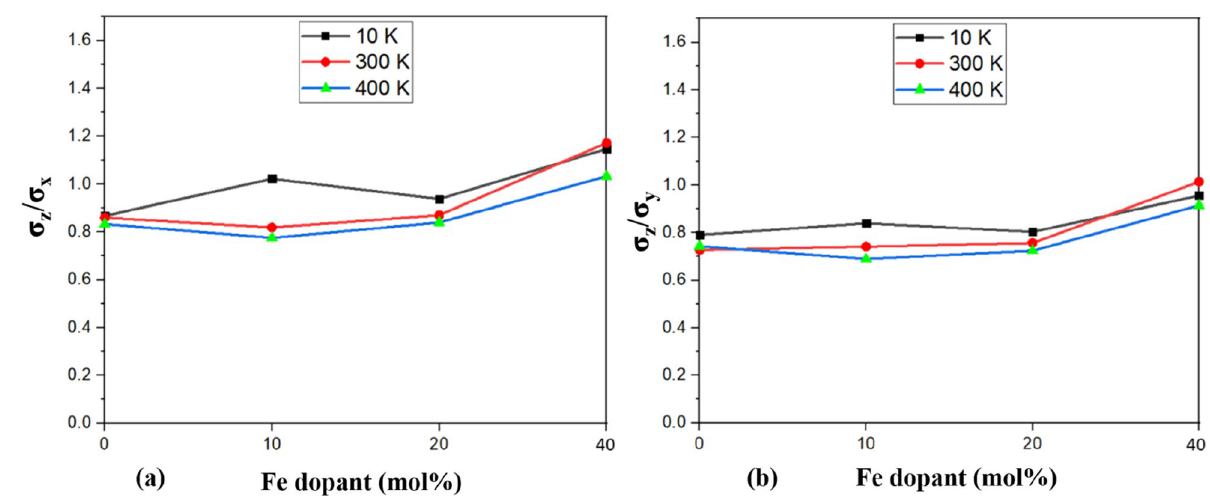
Figure 11. Tensile strength anisotropy (determined using MD simulation) at different temperatures and for doped HA single